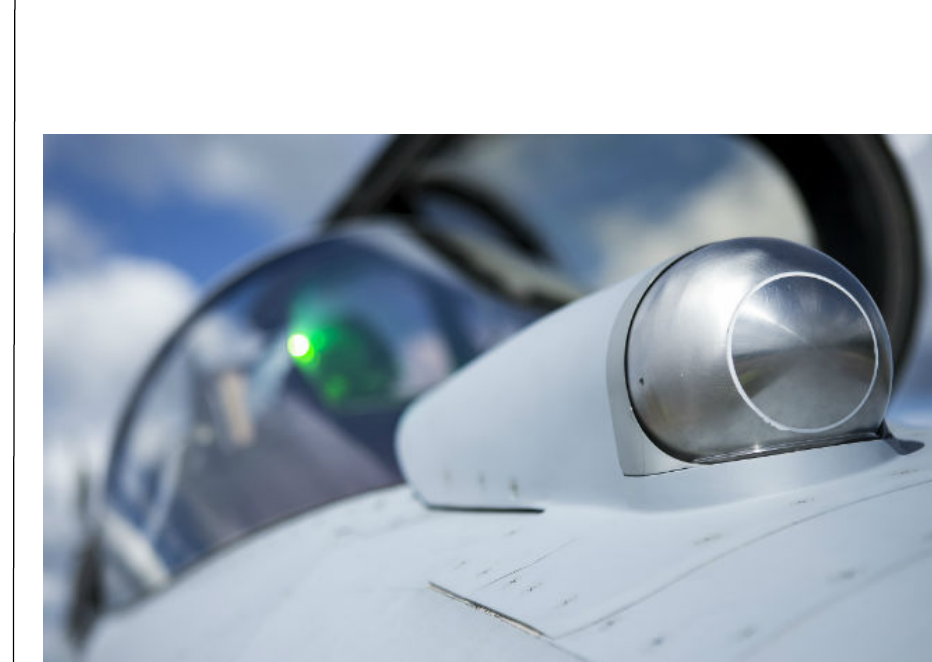
Ure đ aj je smešten na gornjoj strani nosnog konusa aviona i treba da obezbedi novoj generaciji gripena otkrivanje, identifikovanje i pra ć enje cilje- va, putem otkrivanja njihovog toplotnog odraza, što je posebno zna č ajno ka- da se radi o vazduhoplovima sa umanjenim radarskim odrazom. Svrha opit- nog leta bila je provera uspešnosti integracije, te pravilnog funkcionisanja ure đ aja, a prema re č ima predstavnika kompanije Saab postignuti su veoma dobri rezultati. Sistem je, navodno, uspešno otkrio više ciljeva č ime su ispu- njena o č